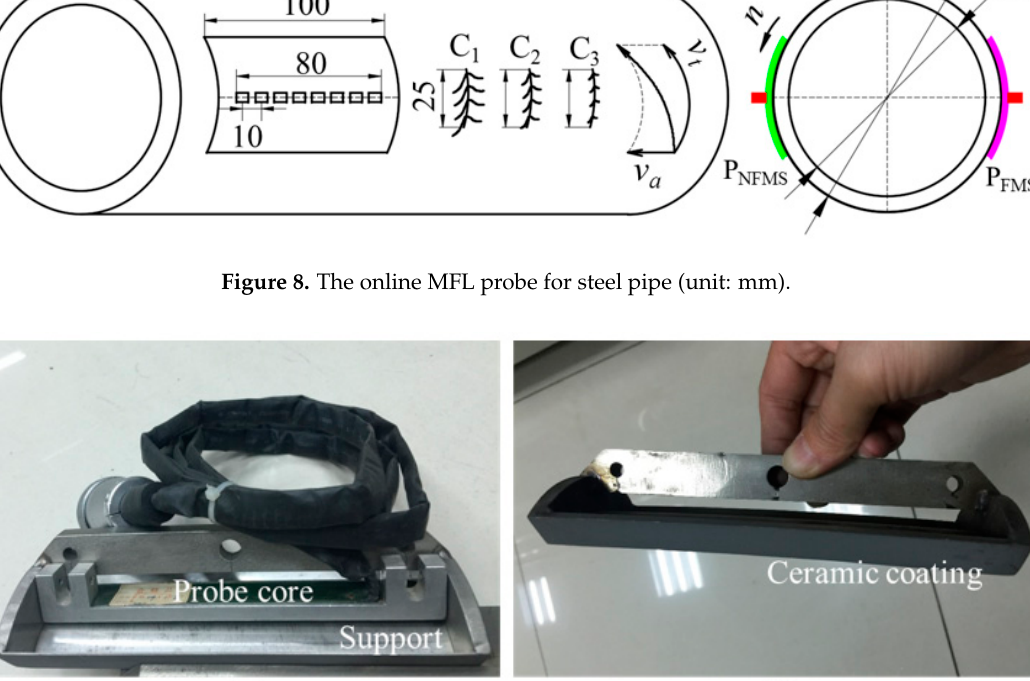
Figure 9. The online MFL probe for steel pipe. ( a ) The overall structure of the probe; ( b ) the ceramic coating painted on the support.